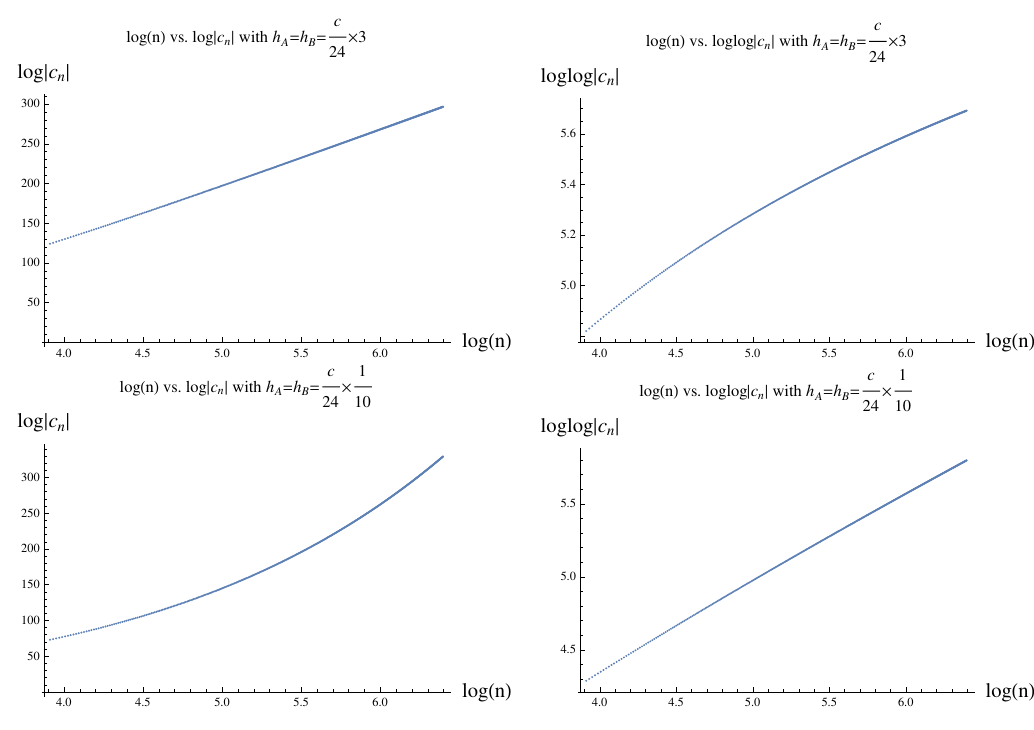
Figure 6 . The plots of c n . The upper two plots are for h A = h B = c grows polynomially. The lower two plots are for h A = h B = c